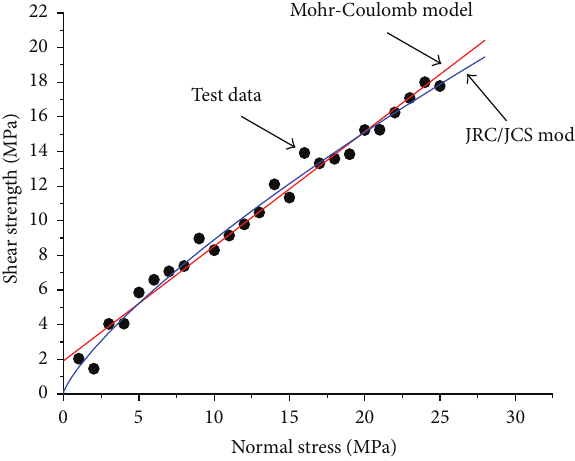
Figure 4: Comparison between numerical calculation and test